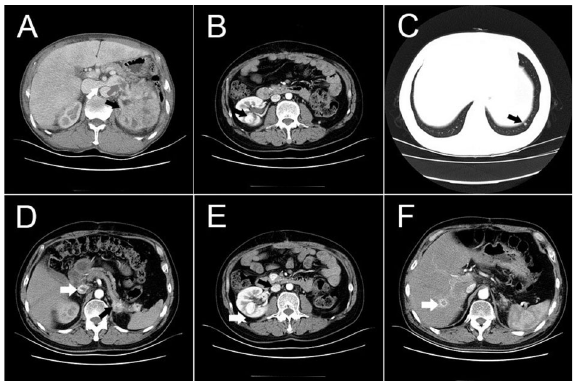
Figure 1. Computed tomography (CT) images of the patient with metastatic renal cell carcinoma at different time points. A , CT image before radical nephrectomy of the left kidney (white arrow: embolus in the inferior vena cava (IVC); gray arrow: embolus in the left renal vein; black arrow: the renal tumor site. November 2003). B , CT image before enucleation of two metastases in the right kidney (black arrow: metastasis in the right kidney. June 2006). C , a distinct metastasis in the left lower lung (black arrow, January 2007). D , CT image revealing the embolus in the IVC (white arrow) and the metastasis in the left adrenal gland (black arrow, November 2011). E , a large metastasis in the right kidney (white arrow) and the embolus in the IVC (black arrow, January 2013). F , a round metastatic site was found in the liver (white arrow, January